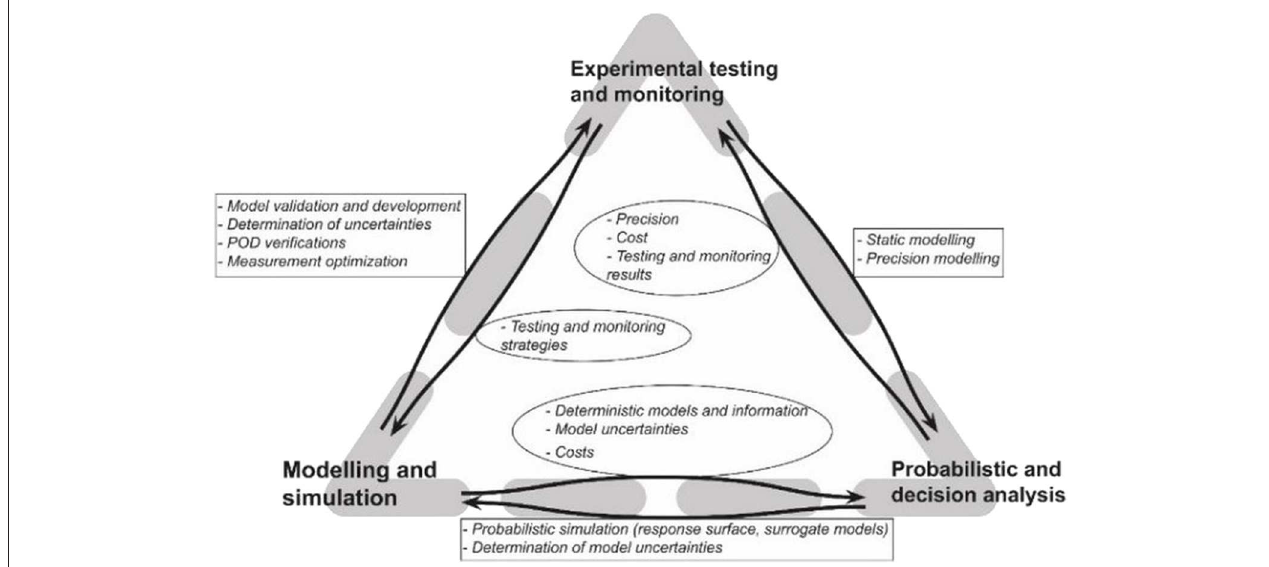
FIGURE 3 | Approach for systematic bridge classification with interfaces between project